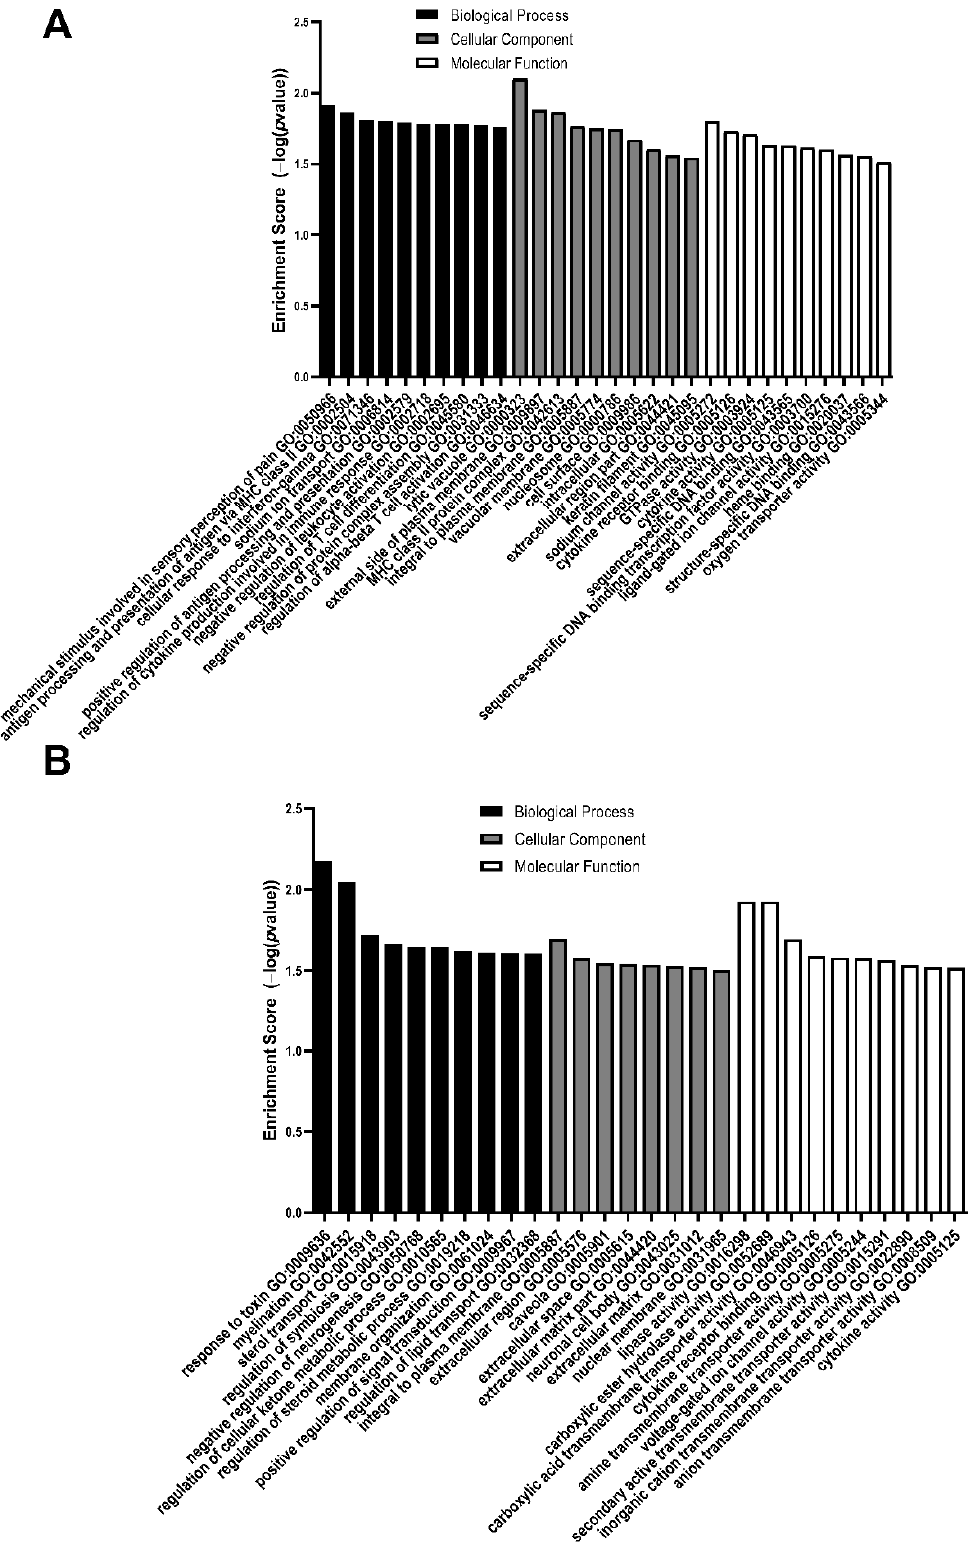
Figure 8. Enrichment scores of the top 10 GO biological processes, cellular components, and molecular function enriched from differentially expressed genes that are ( A ) upregulated or ( B ) downregulated in MMC spinal cords compared to vehicle at E20. All GO pathways were >1.5-fold and p < 0.05.